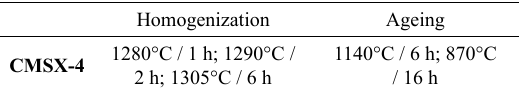
Table 2. Heat treatment employed for CMSX-4 to stabilize the microstructure.